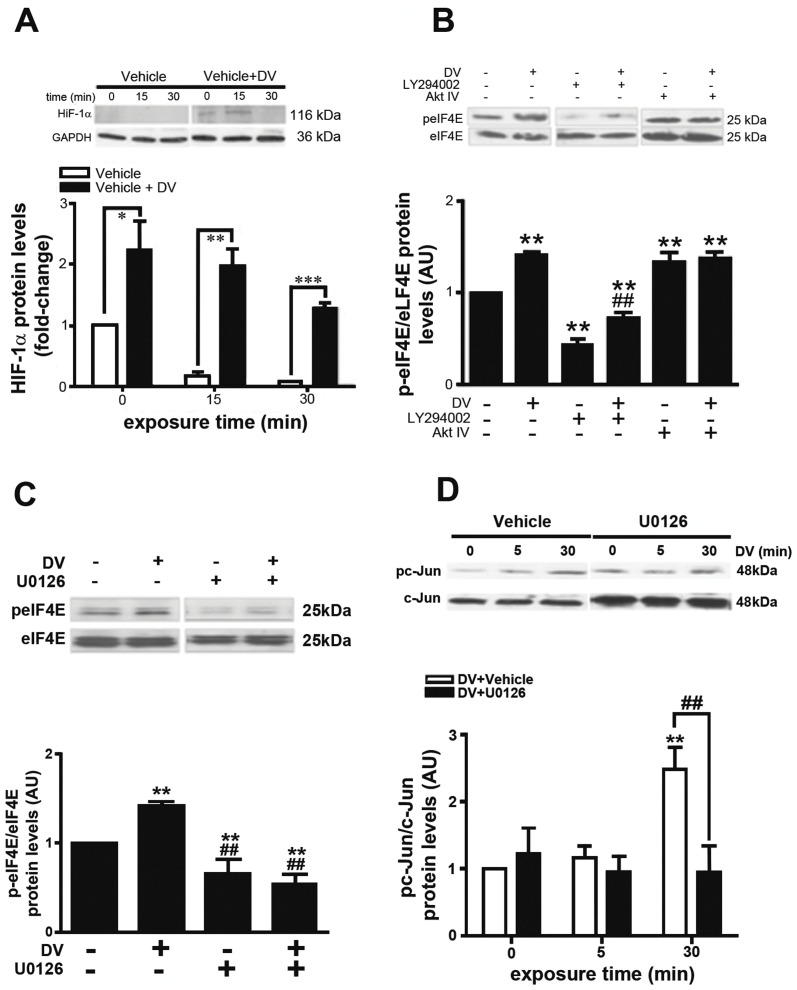
DV induces HIF-1α and increases eukaryotic initiation factor 4E.(A) HIF-1α immunoblot (upper) and OD quantification (lower) following DV exposure. Note the transient HIF-1α band at 5 minutes. N = 3, *P<0.05, **P<0.01 and ***P<0.001 in comparison between vehicle and DV treated cells. (B) Immunoblots (upper) of eukaryotic initiation factor 4E phosphorylation (peIF4E) and total eIF4E after treatment of BECs with combinations of DV, LY294002 and AktIV as labeled. Cells were treated with DV for 5 min. OD quantification (lower) of peIF4E as normalized to total eIF4E. N = 3, **P<0.01 versus untreated cells, ##
P<0.01 within LY294002 treated-group (C) Immunoblots (upper) of peIF4E and eIF4E from BECs treated with combinations of DV and U0126 as labeled demonstrating that U0126 significantly abolished DV-induced peIF4E hyperphosphorylation as OD quantified (lower). Cells were treated with DV for 5 min. N = 3, **P<0.01 versus control, ##
P<0.01 versus DV-treated group. (D) Immunoblots (upper) of phosphorylated c-jun (pc-jun) and total c-jun from BECs treated with DV +/− U0126 demonstrating that U0126 significantly inhibited DV-induced c-Jun phosphorylation as OD quantified (lower). Note the significant increase after 30 min following DV treatment. N = 3, **P<0.01 in comparison to untreated cells, ##
P<0.01 between U0126-treated and untreated cells.